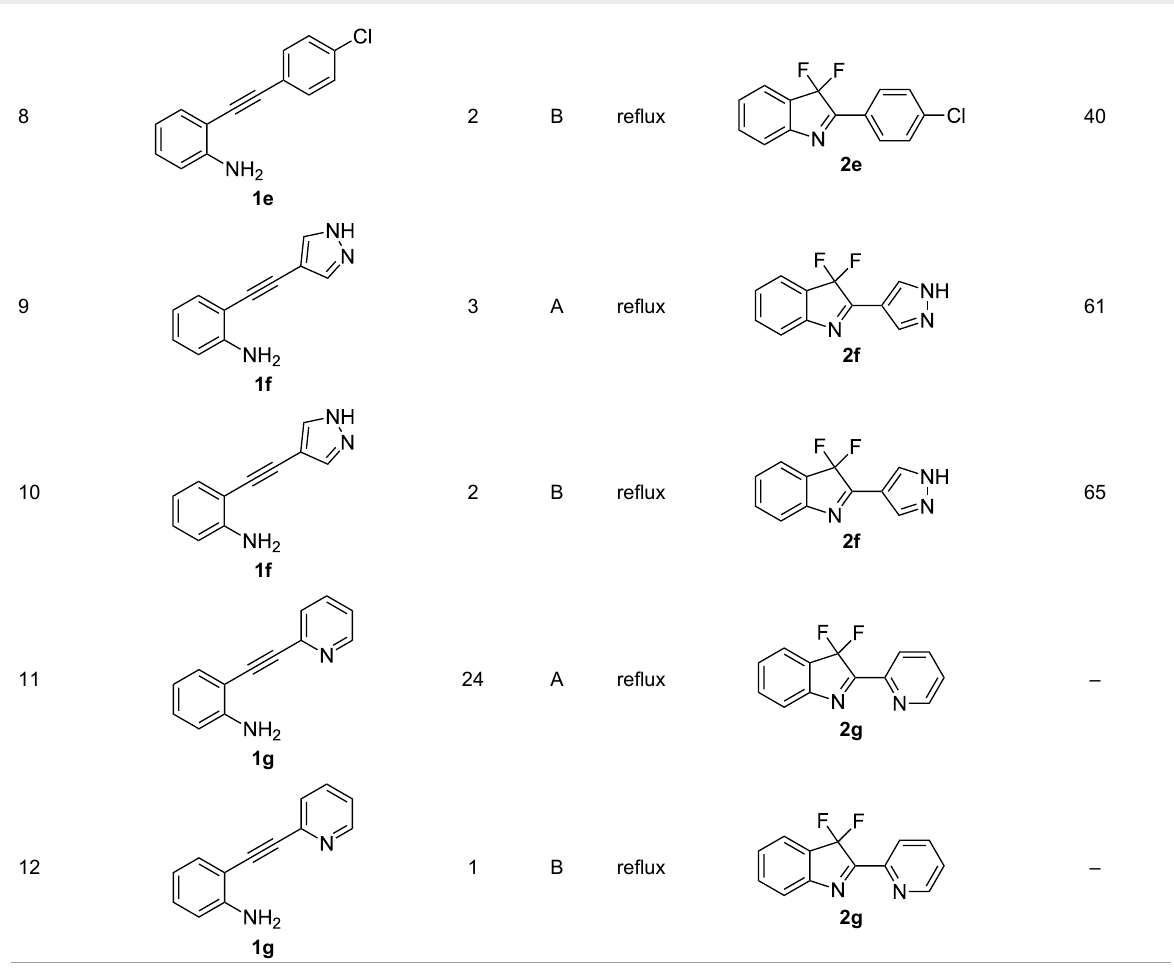
Table 2: Cycloisomerization/fluorination reaction of 2-substituted anilines.